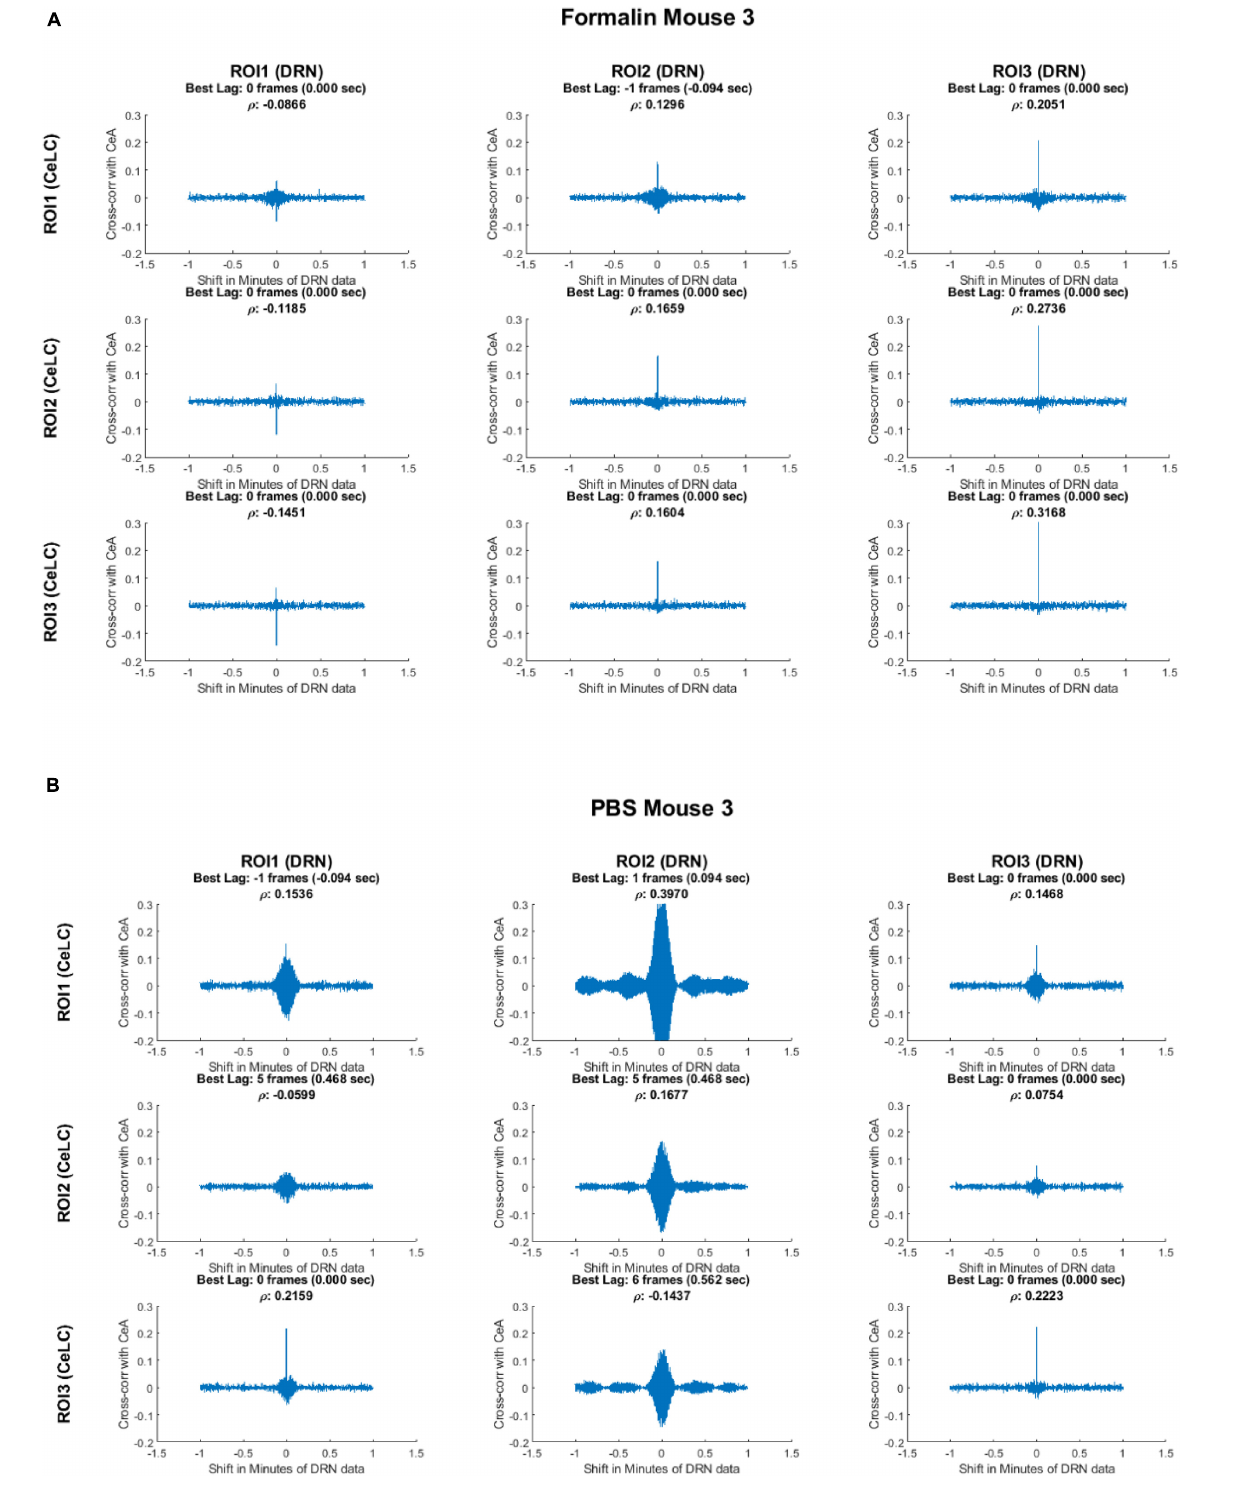
Frontiers in Neuroscience |